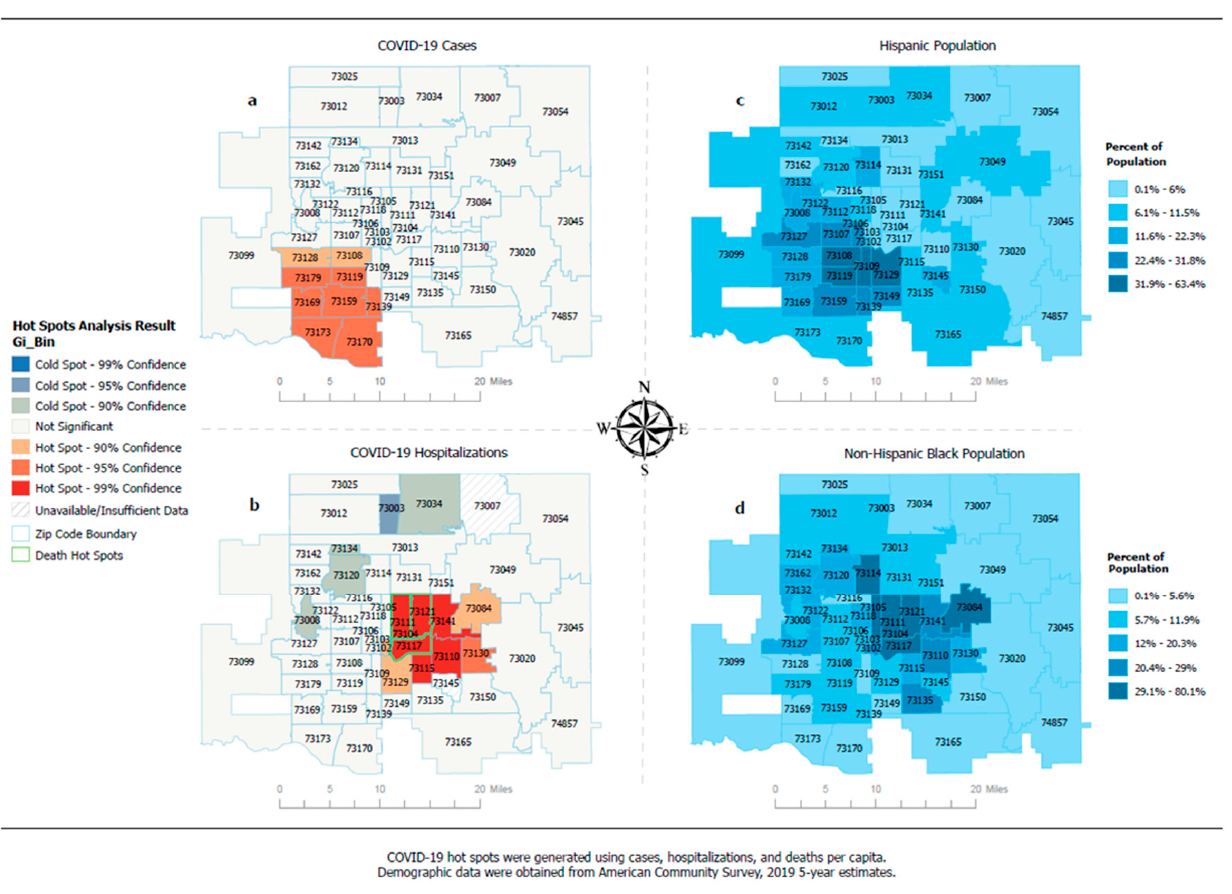
Figure 2. ( a ) Hot spots of COVID-19-related cases. ( b ) Hot spots of COVID-19-related hospitaliza- tions and deaths. ( c ) Distribution of the Hispanic population in the Oklahoma City–County metro- politan area. ( d ) Distribution of the non-Hispanic Black population in the Oklahoma City–County metropolitan area.